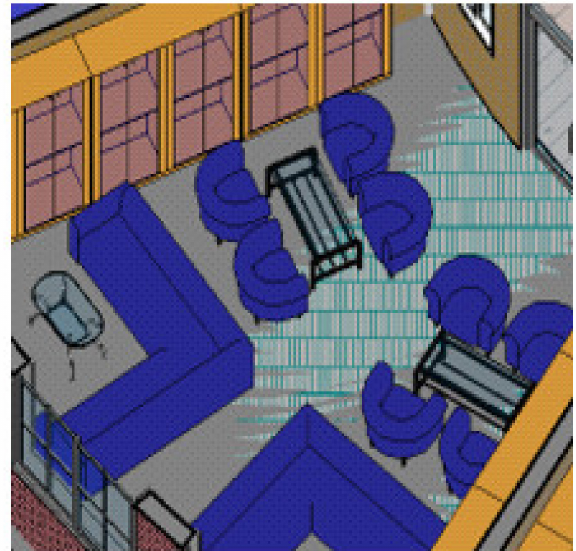
Figure 4. A meeting room in the BIM model.